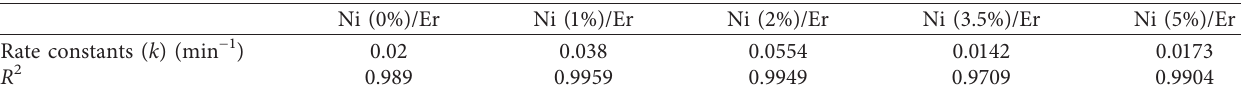
Table 9: Kinetic parameters of 40mg · L − 1 RhB in electrochemical processes by Ti/SnO